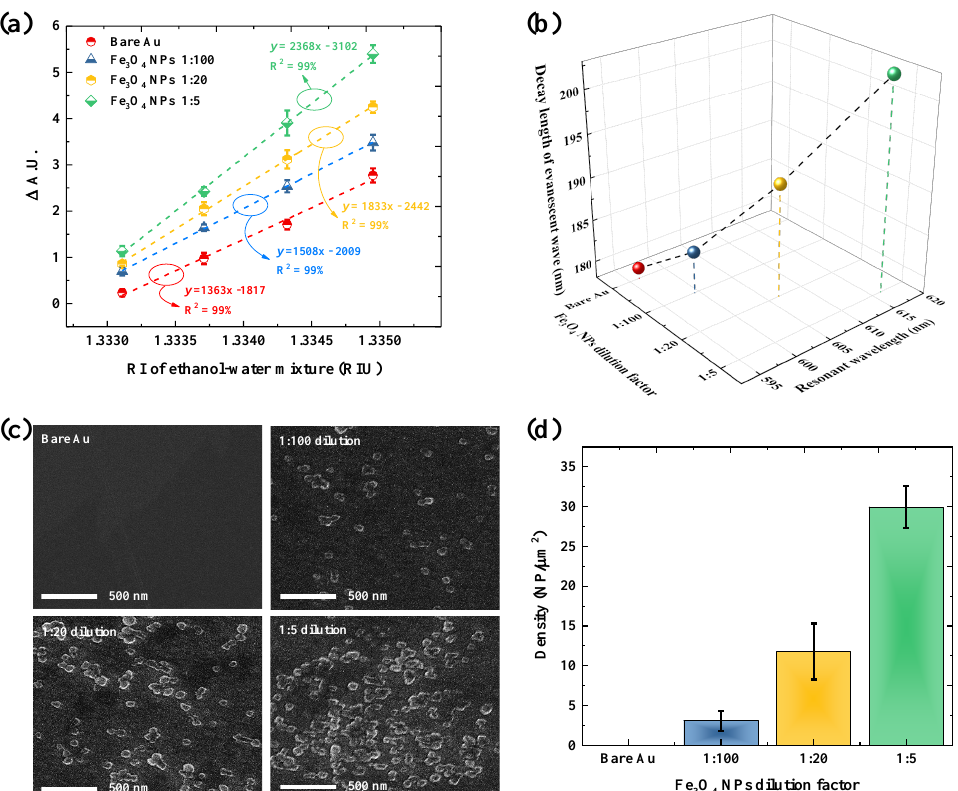
Figure 2. ( a ) Variation of SPR sensitivity in the presence of an ethanol–water mixture by using SA@Fe 3 O 4 NPs with various dilution factors (1:100, 1:20, and 1:5) and bare Au film. ( b ) Effect of different dilutions of Fe 3 O 4 NPs on the position of resonant wavelength and the decay length of evanescent field. ( c ) FE-SEM images and ( d ) the calculated density of nanoparticles for Fe 3 O 4 NPs assembly on Au surface with different dilution